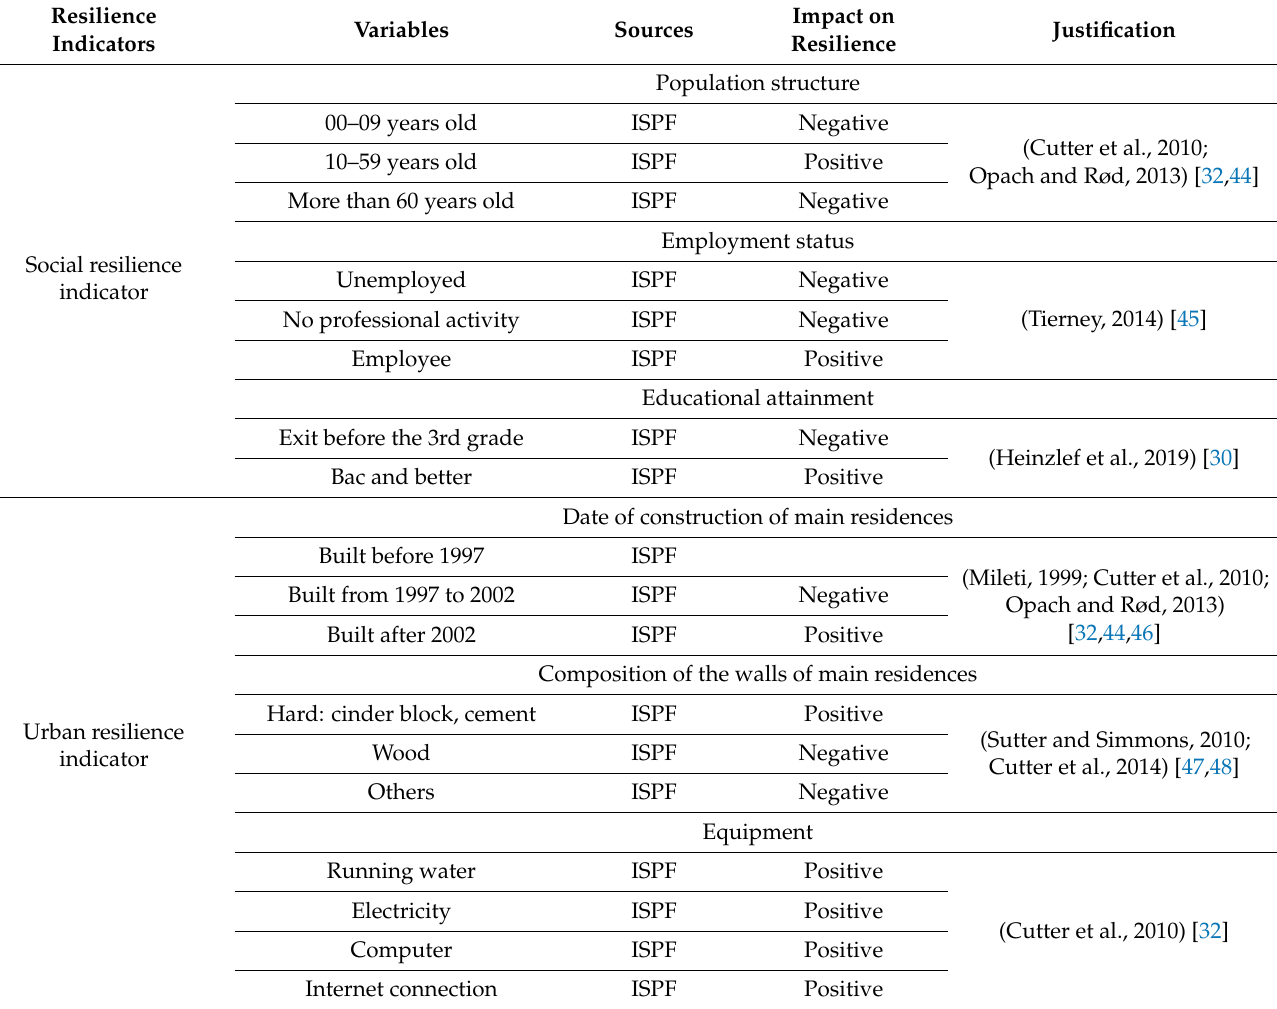
Table 3. Example of data selection, sources and references, adapted from (Heinzlef et al.,